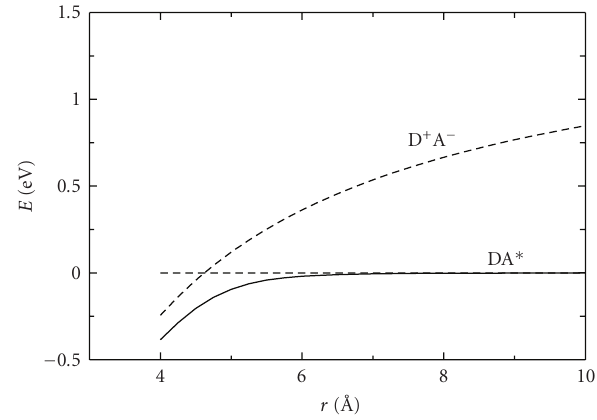
Figure 1: Potential energy curves of a D-A pair with E f ∞ = 1 . 65 eV ( Δ G AN = − 0 . 85 eV) in a nonpolar solvent ( ε S = ε op = 1 . 88). The broken and solid curves represent the diabatic and adiabatic curves, respectively. The parameter values assumed, the molecular radii of D and A, are 3 ˚A, J 0 and β in (9) are 0.23 eV at 4 ˚ A and 1 ˚ A − 1 , respectively. Plotting is made down to r = 4 ˚ A which is smaller than a + b = 6 ˚A. This is not meaningless because D and A are often not spherical but planar and can approach to distances shorter than a + b